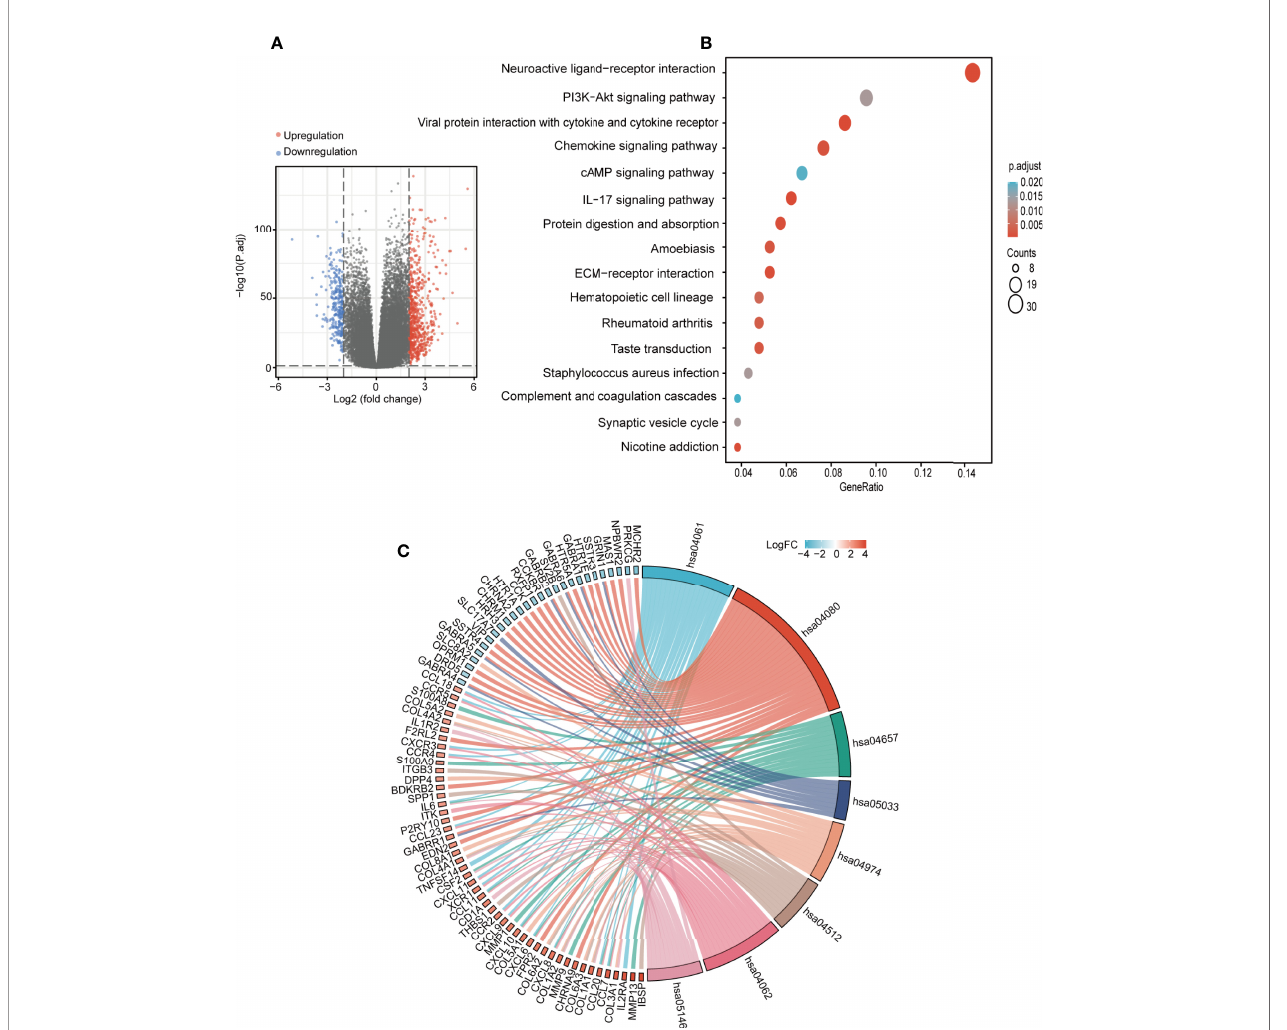
FIGURE 7 | SOAT1 was involved in a variety of pathways and BPs in glioma. (A) Volcano plot of DEGs between the high SOAT1 and low SOAT1 expression groups based on TCGA cohort. (B) KEGG enrichment analysis of SOAT1 in glioma based on TCGA cohort. (C) Chordal graph of signi fi cantly enriched pathways and BPs of SOAT1 in glioma as shown by KEGG analysis based on TCGA cohort. hsa04080, neuroactive ligand-receptor interaction; hsa04061, viral protein interaction with cytokine and cytokine receptor; hsa04657, IL-17 signaling pathway; hsa05033, nicotine addiction; hsa04974, protein digestion and absorption; hsa04512, ECM-receptor interaction; hsa04062, chemokine signaling pathway; hsa05146, amoebiasis. SOAT1 , sterol O-acyltransferase 1 ; DEGs, differentially expressed genes; TCGA, The Cancer Genome Atlas; KEGG, Kyoto Encyclopedia of Genes and Genomes; BPs, biological